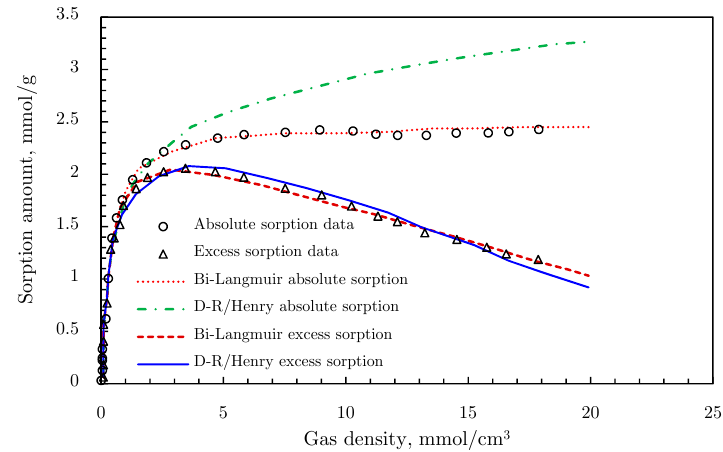
Figure 26. The comparison of Bi-Langmuir model with CO 2 experimental sorption data on coal and D-R / Henry combination model. Energies 2020 , 13 , 5427